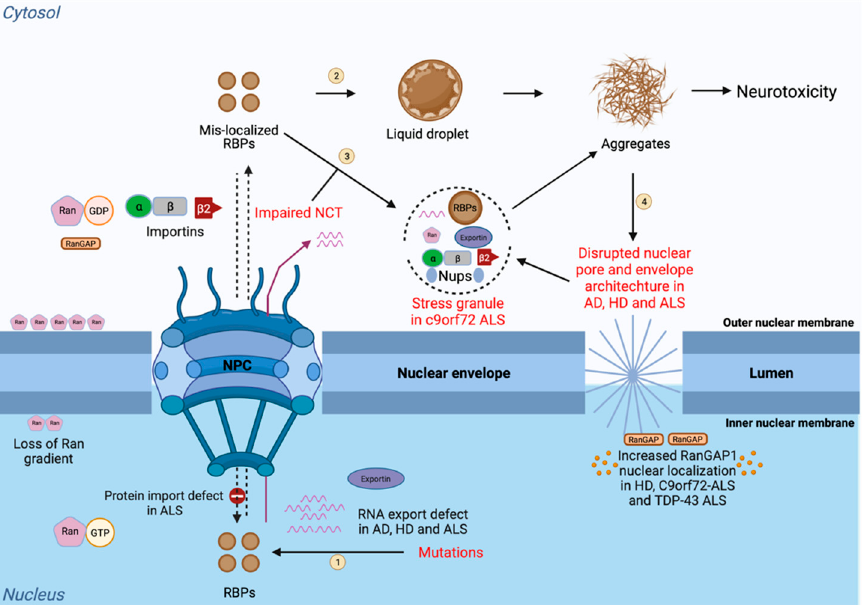
Figure 2. Disease-linked defects in the NCT. Protein transport (import and export) and RNA export are tightly regulated processes through the nuclear pore that depend on different NCT elements, including nucleoporins (Nups), importins, exportins, and transport factors, together with Ran and its regulatory components. The steps in the process are as follows: (1) Mutations in RNA-binding proteins lead to its mislocalization to the cytoplasm from the nucleus; (2) In the cytoplasm, these mislocalized RBPs can undergo liquid–liquid phase separation and aberrant phase transition to form irreversible aggregates; (3) RBPs can also participate in membraneless organelles, such as stress granule, which can further form irreversible aggregates. Impairments in the NCT also lead to the mislocalization of RBPs in the cytoplasm and cause their accumulation in phase-separated biocondensates which can further convert into irreversible toxic aggregates leading to neurotoxicity; and (4) In the presence of toxic aggregates generated from RBPs, the nuclear pore integrity and the nuclear membrane morphology are compromised, leading to the uncontrolled transport of proteins and RNAs. Due to this, the Ran gradient becomes impaired and causes an abnormal accumulation of Ran in the cytoplasm and abnormal RanGAP localization in the nucleus. Mislocalization of RBPs causes sequestering of NCT factors, such as importins and nucleoporins, into the cytoplasm-forming SG. SG formation further disrupts the process, due to the generation of neurotoxic aggregates. This figure was created with